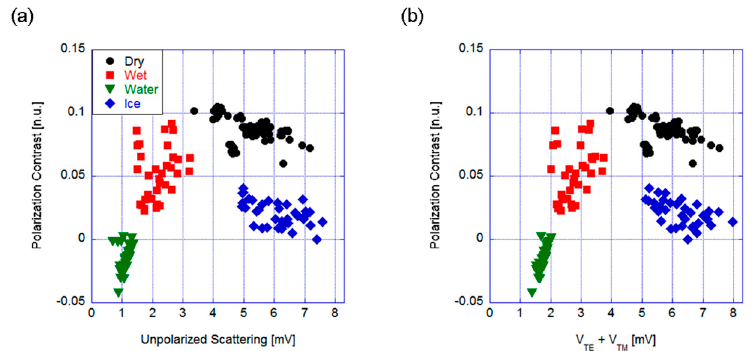
Figure 5. Backscattering configuration. Polarization contrast versus ( a ) the total scattering and ( b ) the sum of the two orthogonal polarized components.